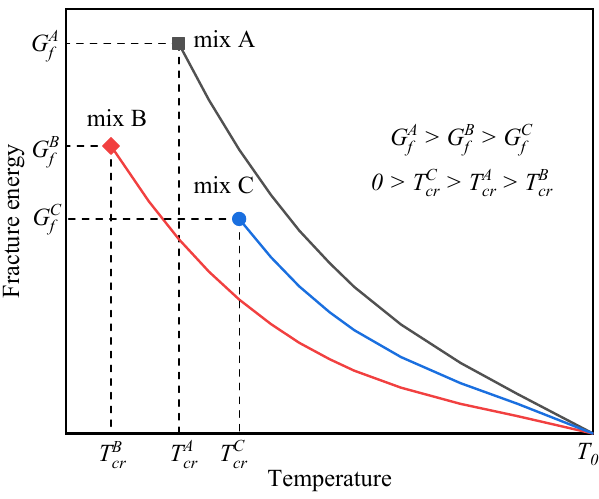
Figure 2. Schematic of FE and CCT.